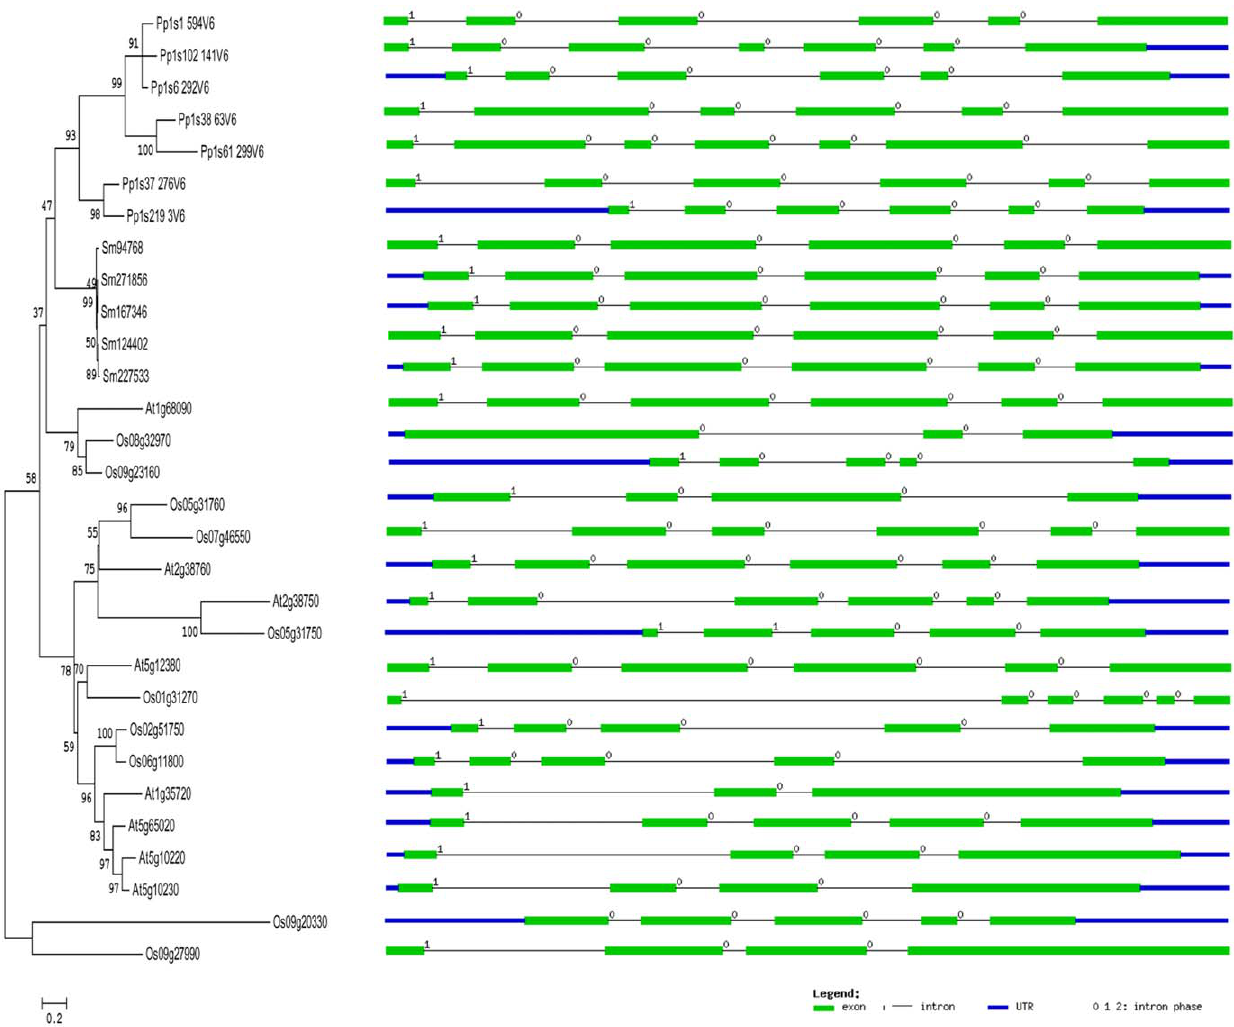
Figure 5. Gene structures of annexins from four representative genomes (moss, spike moss, Arabidopsis and rice) in plant lineage. The intron phases are highly conserved in all the genomes and represented in the maximum likelihood phylogeny tree. As shown in the legend, the intron phases in between exon-intron junctions are given as 0 and 1, exons are represented by green filled boxes, introns by black lines and untranslated regions (UTR) by blue filled boxes. The scale bar represents 0.2 amino acid substitutions per site. The gene structures were drawn using online tool Gene Structure Display Server (http://gsds.cbi.pku.edu.cn/).